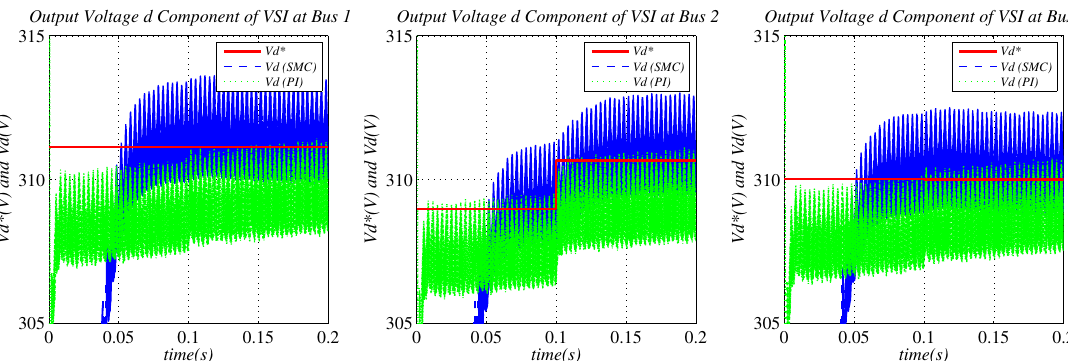
Figure 10. Output voltage d components of the VSI at Buses 1, 2, and 3 (comparison of the SMC and PI controls).